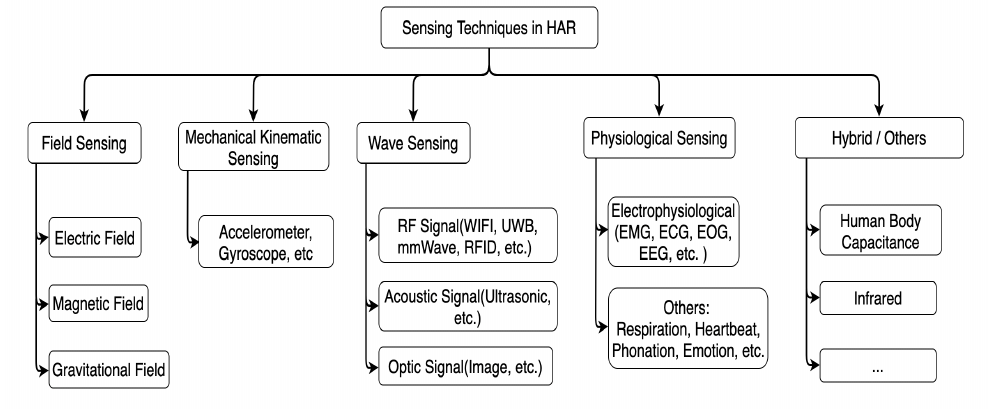
Figure 1. Sensing techniques in human activity recognition.